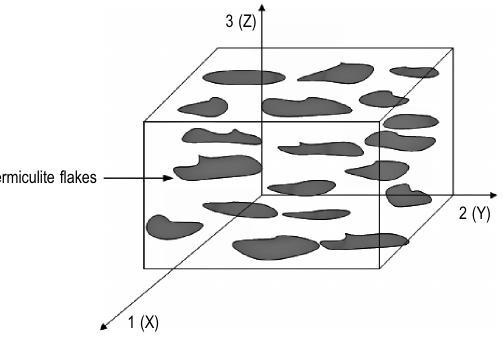
Fig. 6. Definition of the coordinate